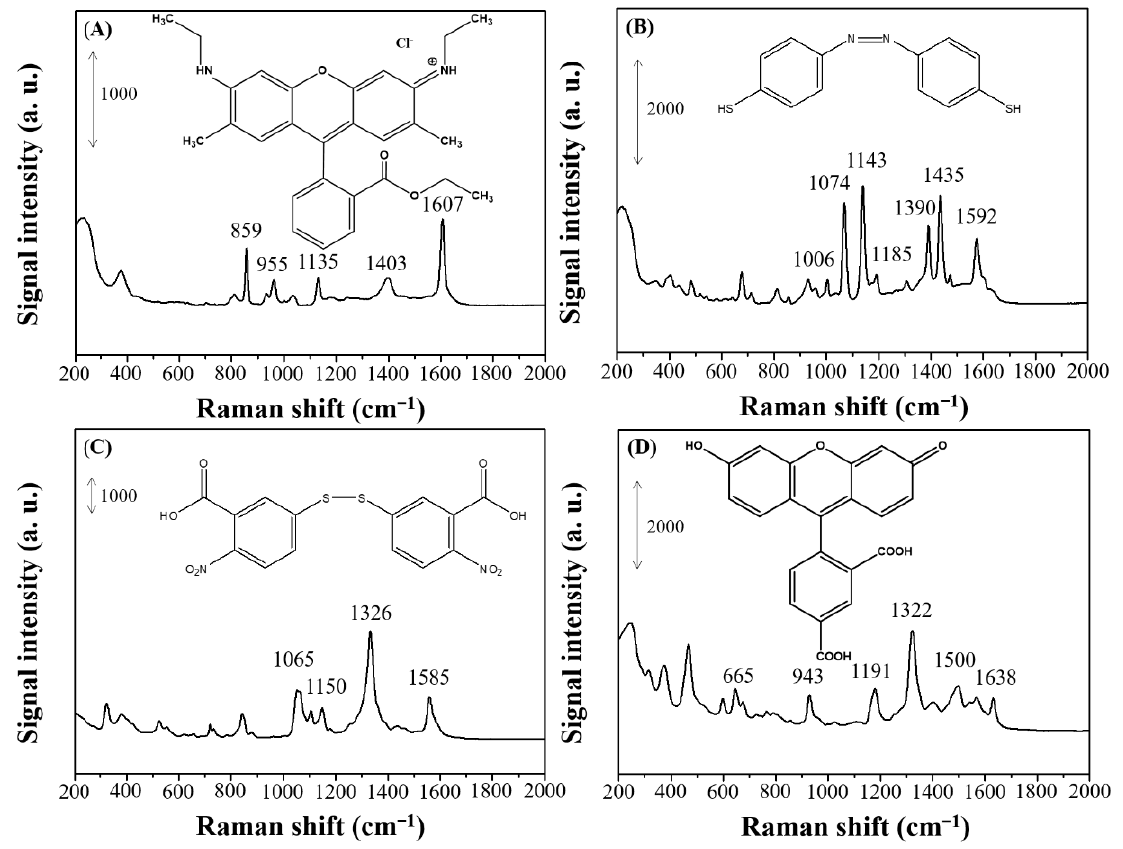
Figure 11. SERS spectra of ( A ) R6G, ( B ) 4-ATP, ( C ) DTNB, and ( D ) FAM molecules for the dendritic forest-like Ag nanostructures.